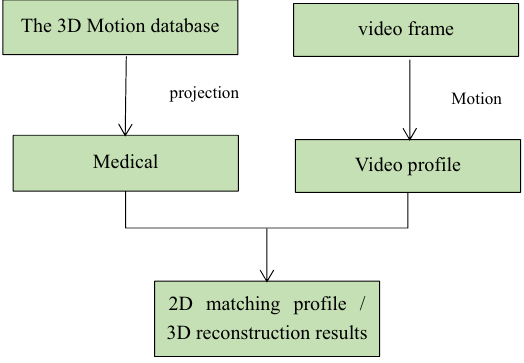
Figure 3: Basic fl ow chart of human posture reconstruction.